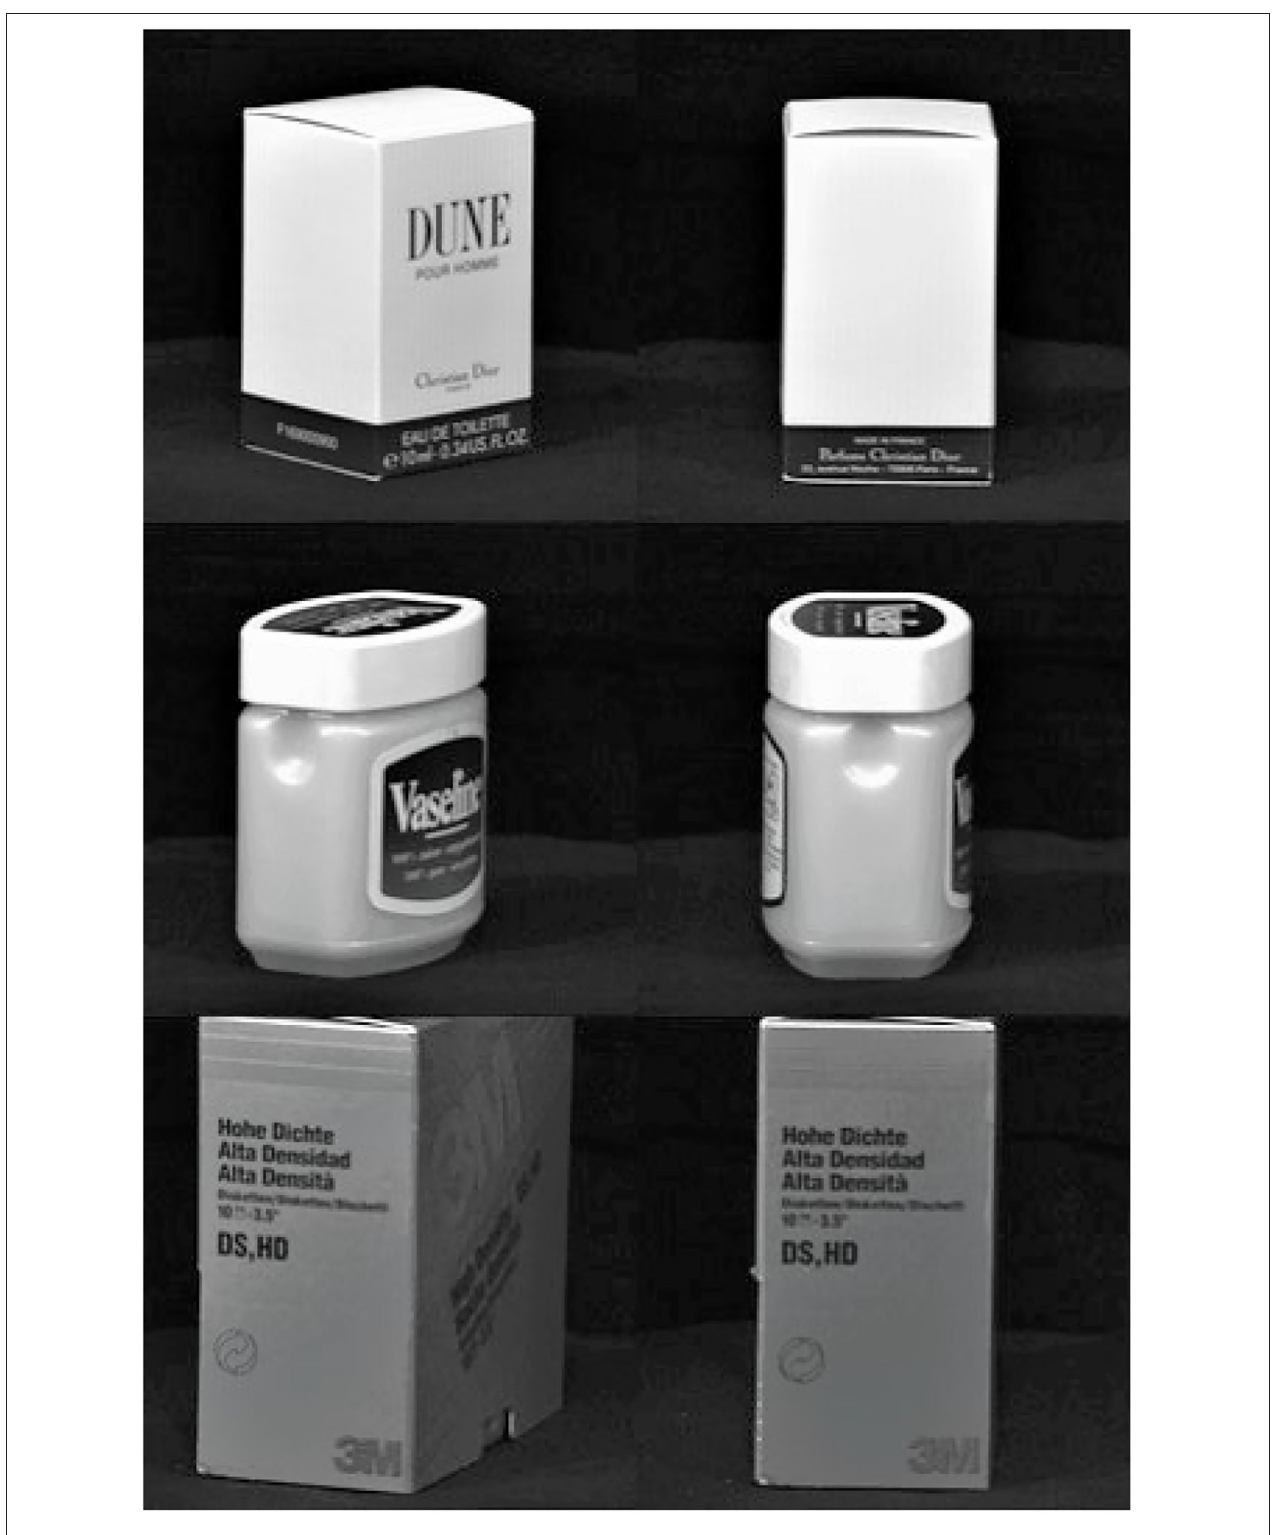
FIGURE 6 | Objects with similar shapes placed in different classes: first line neutral palmar, second and third lines pronated palmar.